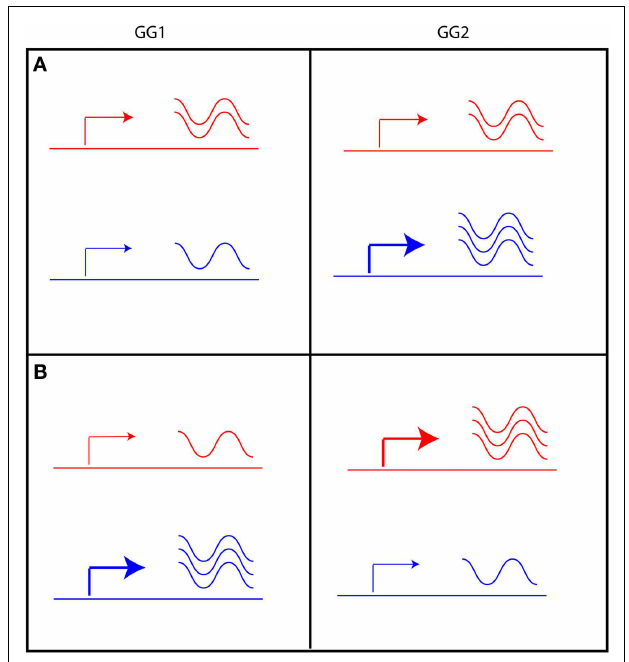
FIGURE 4 |Two scenarios can explain eQTLs with opposite effect in GG1 and GG2. The level of expression of a given gene in L er (red) and Cvi (blue) is indicated by the arrow, indicating low (thin arrow) or high (thick arrow) promoter activity resulting in a low or high level of transcript (indicated by the waving lines). (A) gene expression in L er is unchanged, but in Cvi it is plastically regulated. (B) gene expression is plastically regulated in both L er and Cvi, but activation of expression is stronger in GG1 of the Cvi allele and in GG2 of the L er allele.